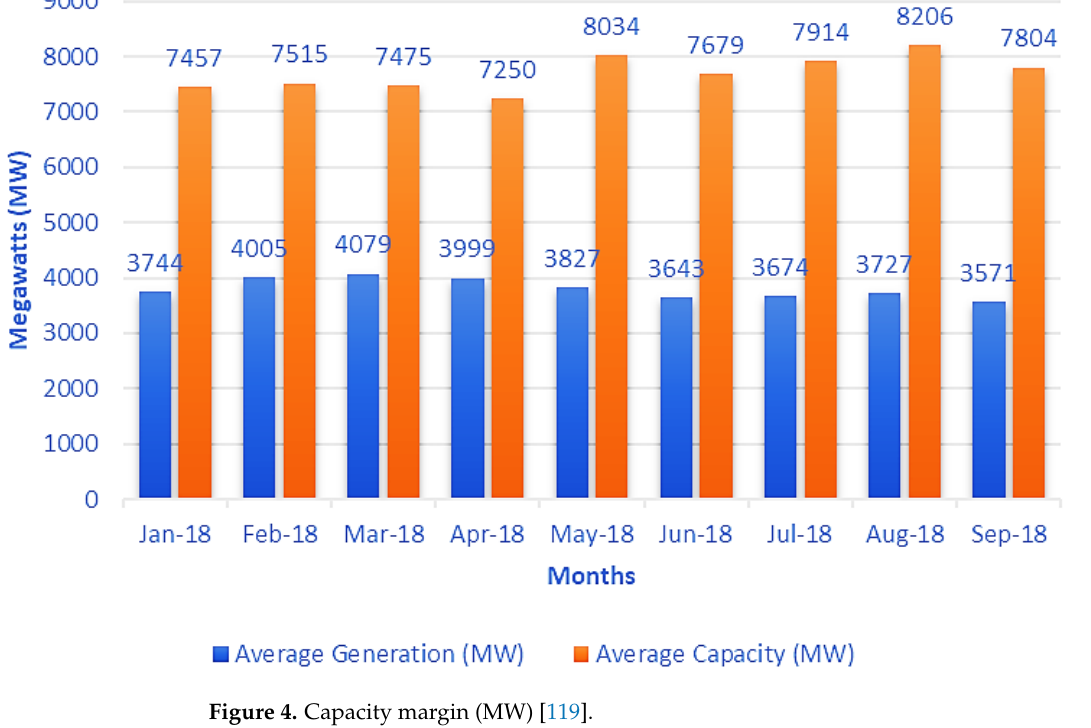
Figure 4. Capacity margin (MW) [119].